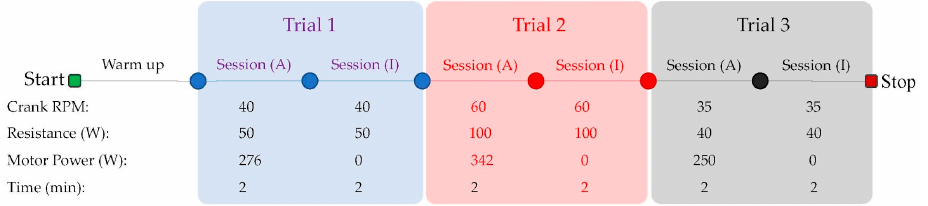
Figure 4. Experimental protocol at three different cadences and motor power assistance which occurred during Trials 1 to 3. Each trial consisted of two sessions of a pedaling task, where the APAD system was active in session (A) and inactive in session (I).